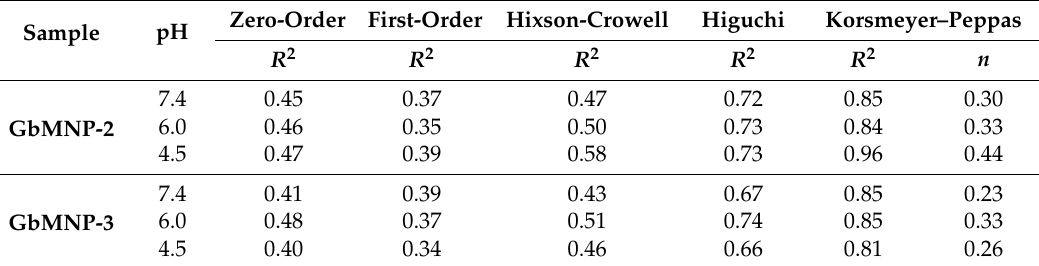
Table 4. The in vitro drug release kinetics studies of GbMNPs.